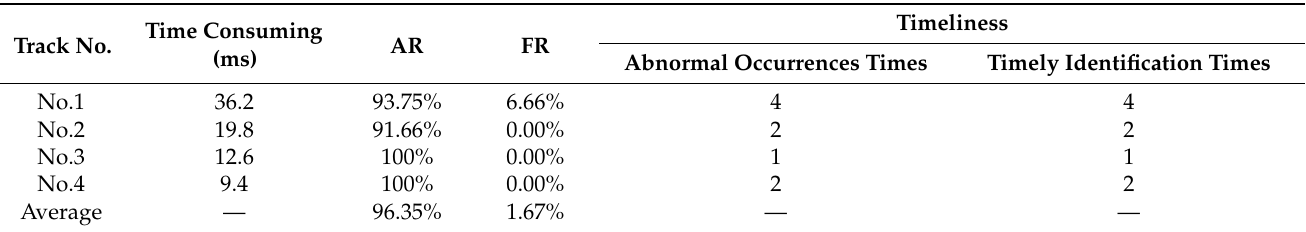
Table 12. Evaluation of ship trajectory anomaly detection results based on BiGRU.